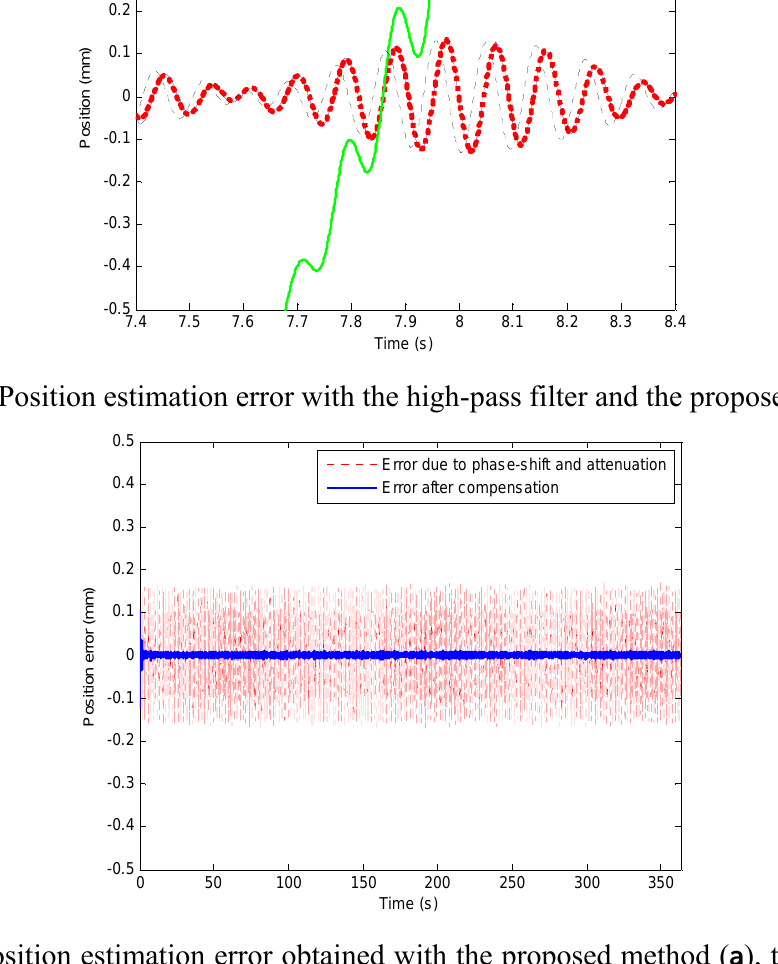
Figure 12. Position estimation error obtained with the proposed method ( a ), the analytical integration without the simulated hardware filter ( b ), and the analytical integration with the filter ( c